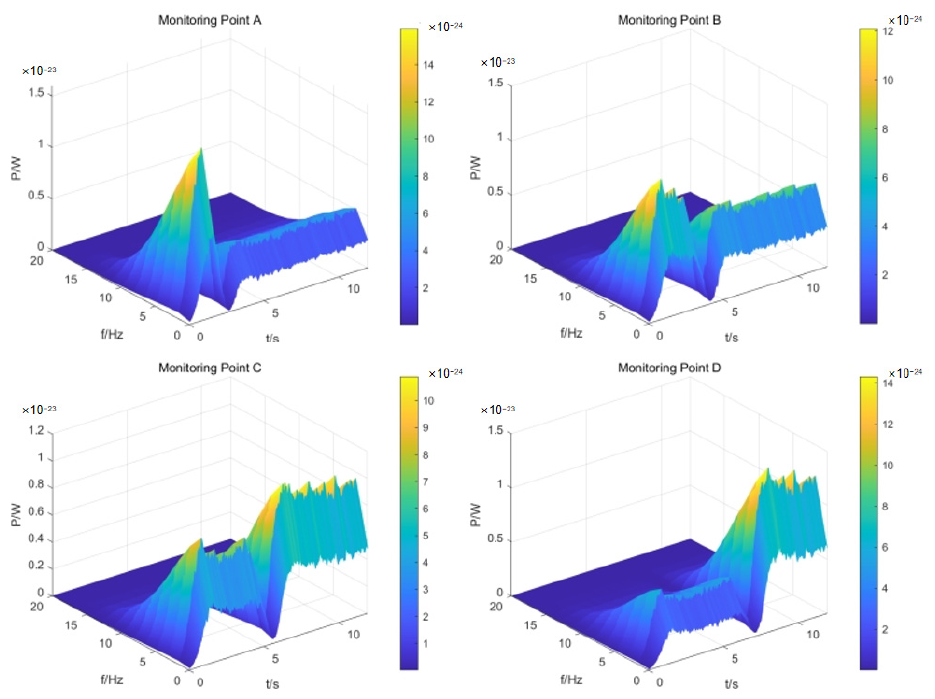
Figure 10. The time-frequency domain diagram of the magnetic field at the monitoring point when the submarine moves at a speed of 2.5 m/s.